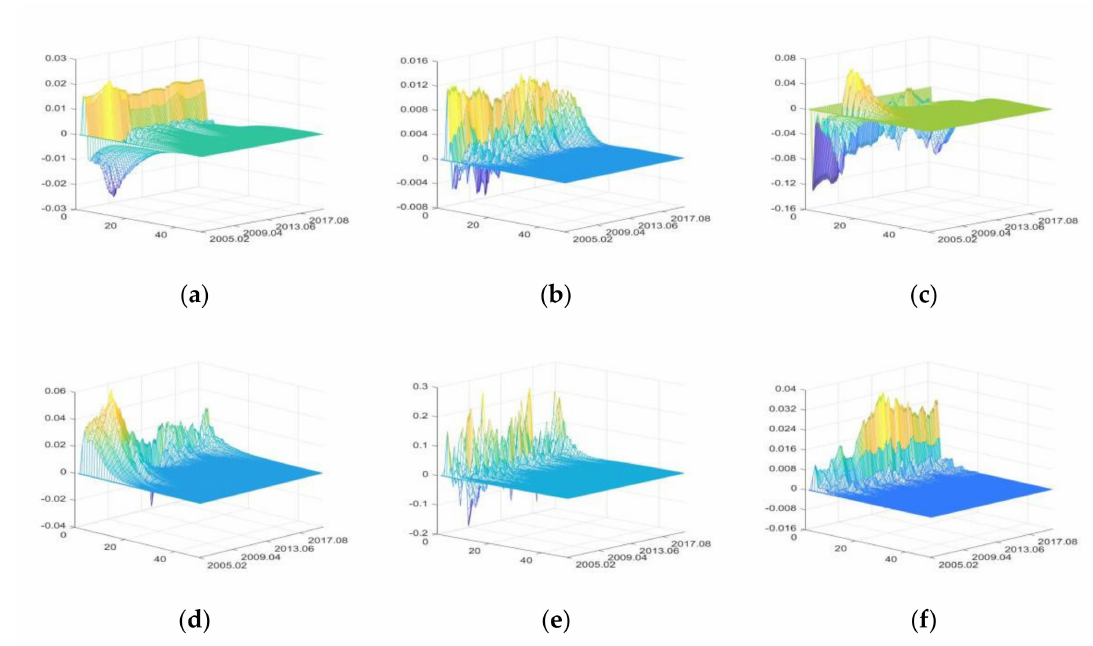
Figure 8. The three-dimensional impulse responses of PAI to positive shocks of external uncertainties. ( a ) Shocks of IRU. ( b ) Shocks of FU. ( c ) Shocks of SDU. ( d ) Shocks of CU. ( e ) Shocks of DE. ( f ) Shocks of